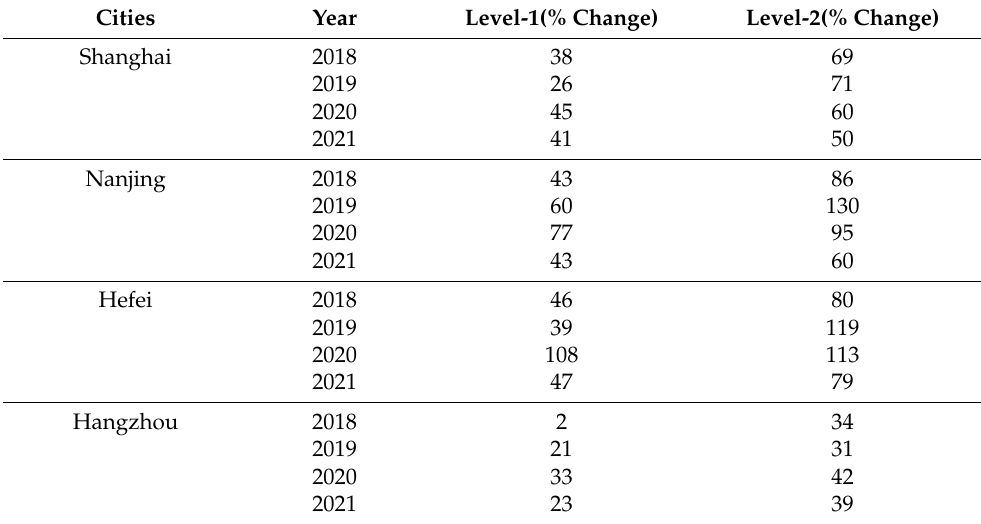
Table 4. Percentage change in mean O 3 during lockdown levels (Level-1(24 January–26 February) and Level-2 (27 February–31 March)) with reference to Pre-lockdown Phase (1 January–23 January).